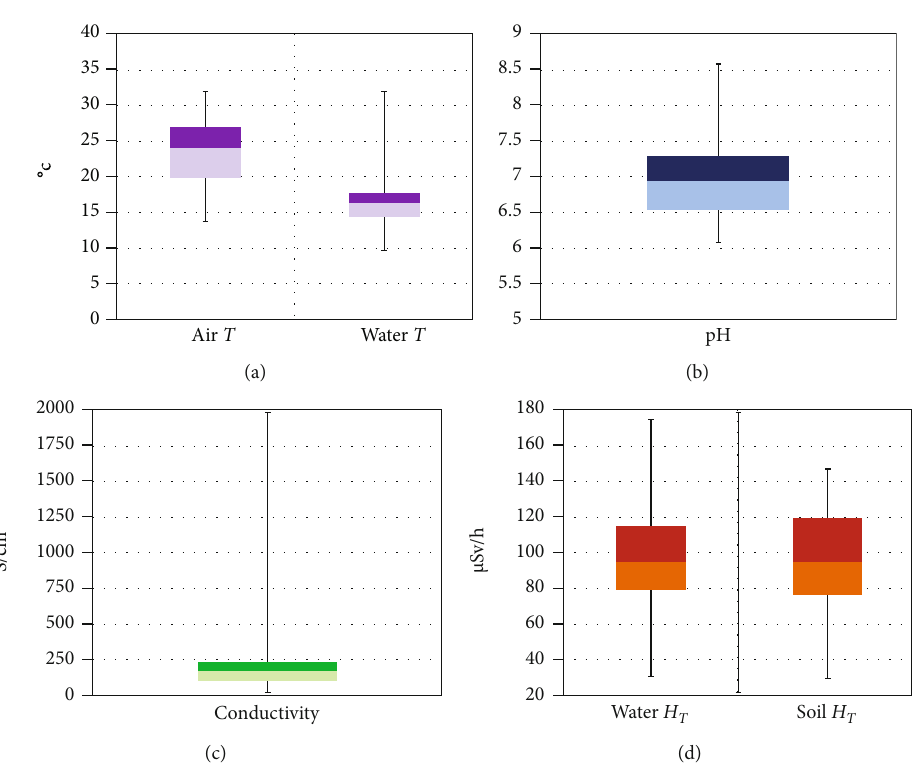
Figure 3: Boxplots of measured parameters.